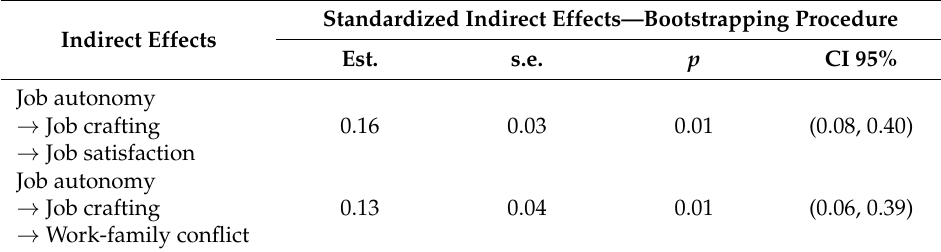
Table 3. Indirect effects of the estimated SEM using